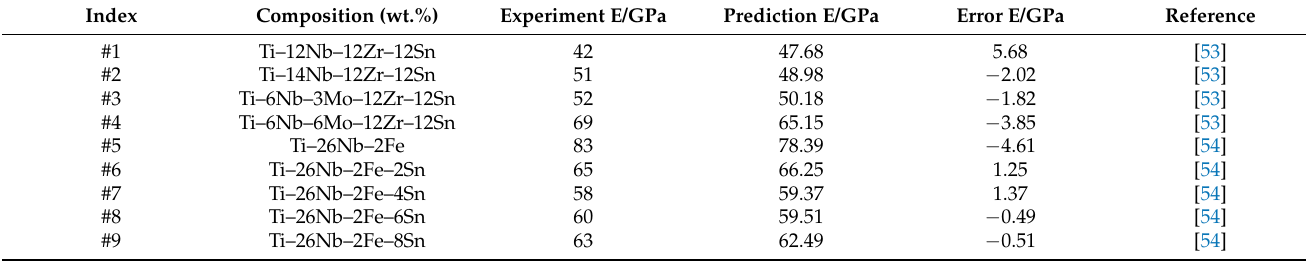
Table 4. Alloy compositions and experimental Young’s modulus were collected from the latest reported literature to estimate the prediction performance of the models.